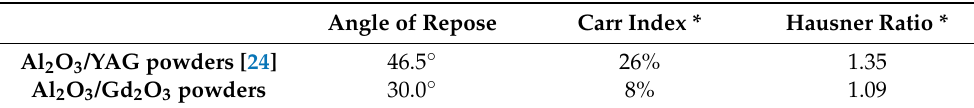
Table 2. Angle of repose, Carr index and Hausner ratio of Al 2 O 3 /YAG and Al 2 O 3 /Gd 2 O 3 sprayable